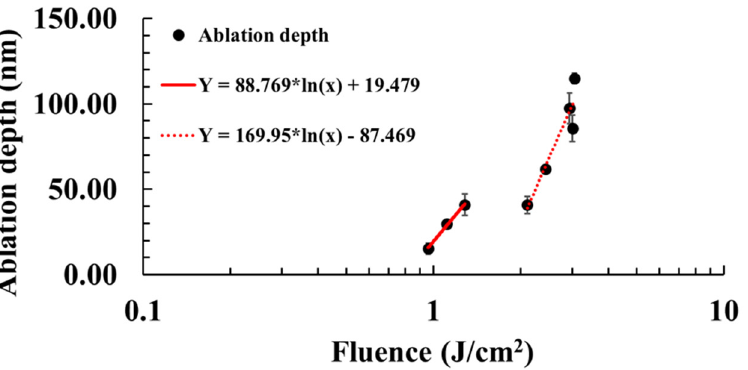
Figure 3. The ablation depth against laser fluence.